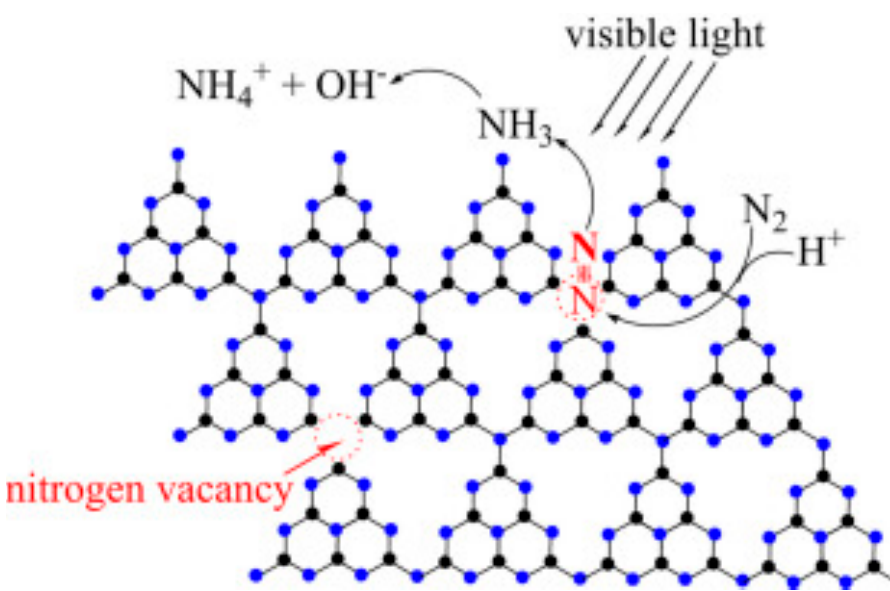
Figure 11. The possible nitrogen photofixation process proposed by Ma et al. (Reproduced with permission from Elsevier [68]).